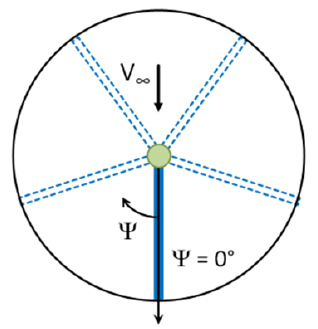
Figure 11. Definition of the azimuthal rotor blade